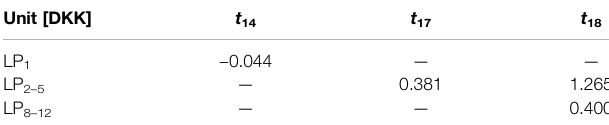
TABLE 2 | DTS at load points in scenario 1.